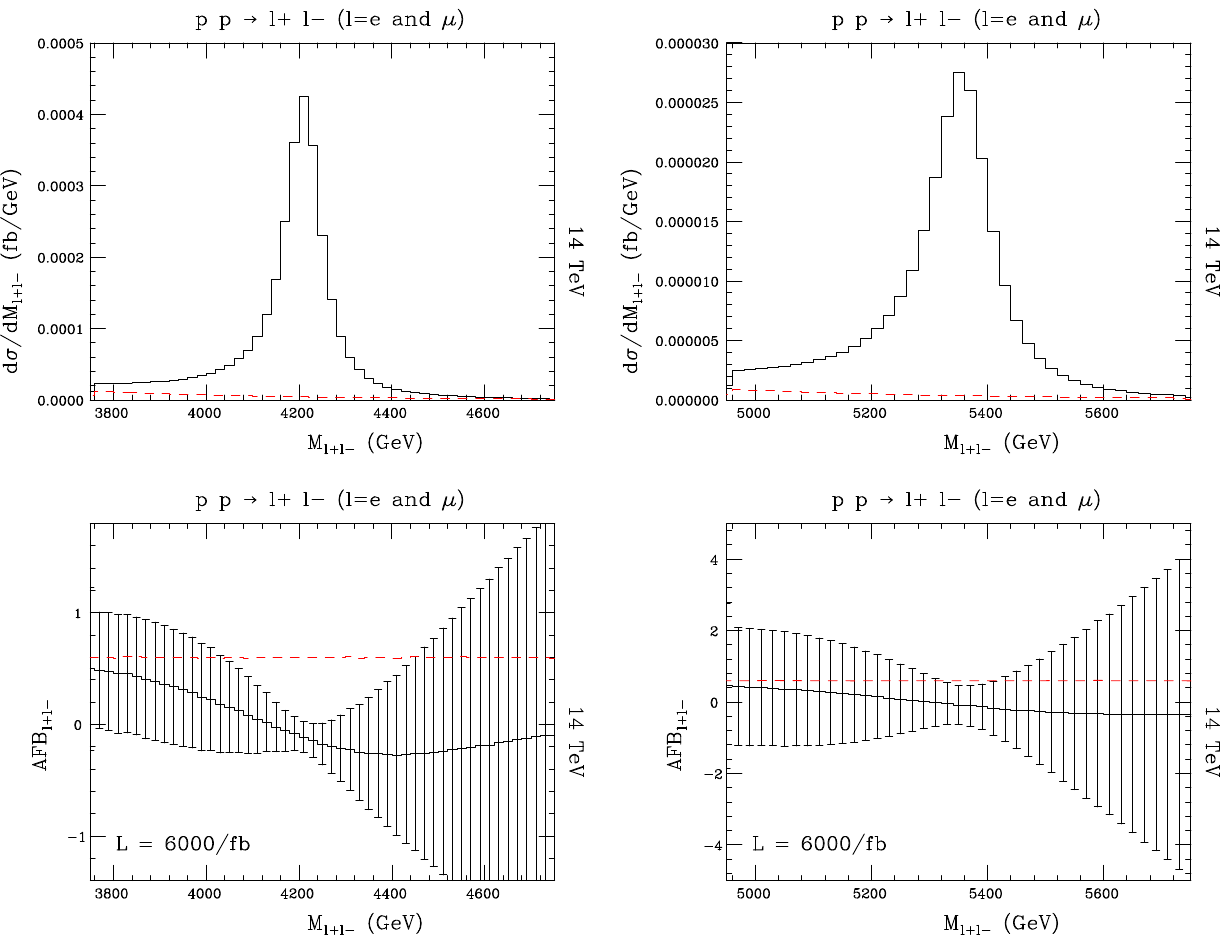
Fig. 1 (Top) Distribution of the cross section vs the di-lepton invariant massforDYproductionintheE 6 SSM(solidblack)andSM(dashedred) √ s = 14 TeV. (Bottom) Distribution of the Forward– at the LHC with Backward Asymmetry vs the di-lepton invariant mass for DY produc- Fig. 2 Left: Feynman diagram of inert chargino’s pair production followed by the decay into inert higgsino DM, soft leptons and Missing Transverse Energy (MET) that generate a disappearing tracks signature. Right: Inert chargino pair production followed by the decay into a